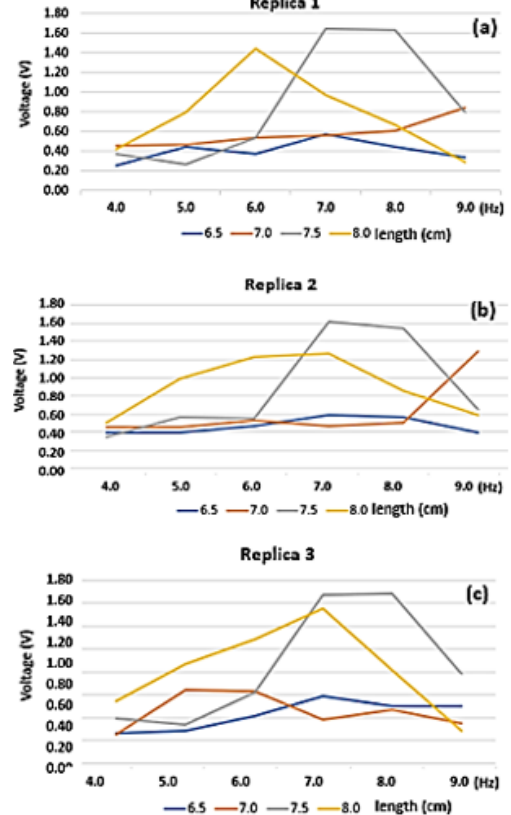
Figure 27. Energy-harvesting tests for the implemented piezoelectric system. ( a ) Replica 1; ( b ) Replica 2; and ( c ) Replica